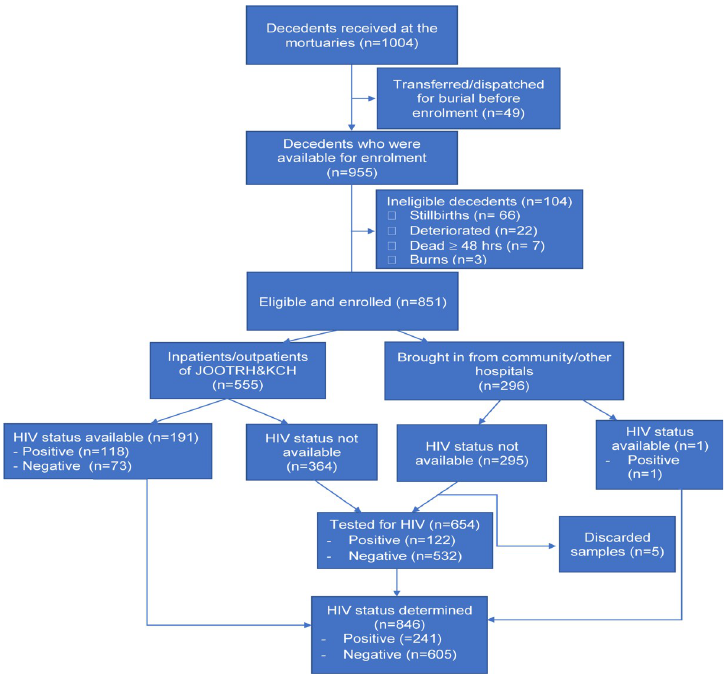
Fig 1. Flowchart depicting the source of decedents received by JOOTRH and KCH mortuaries, eligibility and source of their HIV status, Kisumu County, 2019.